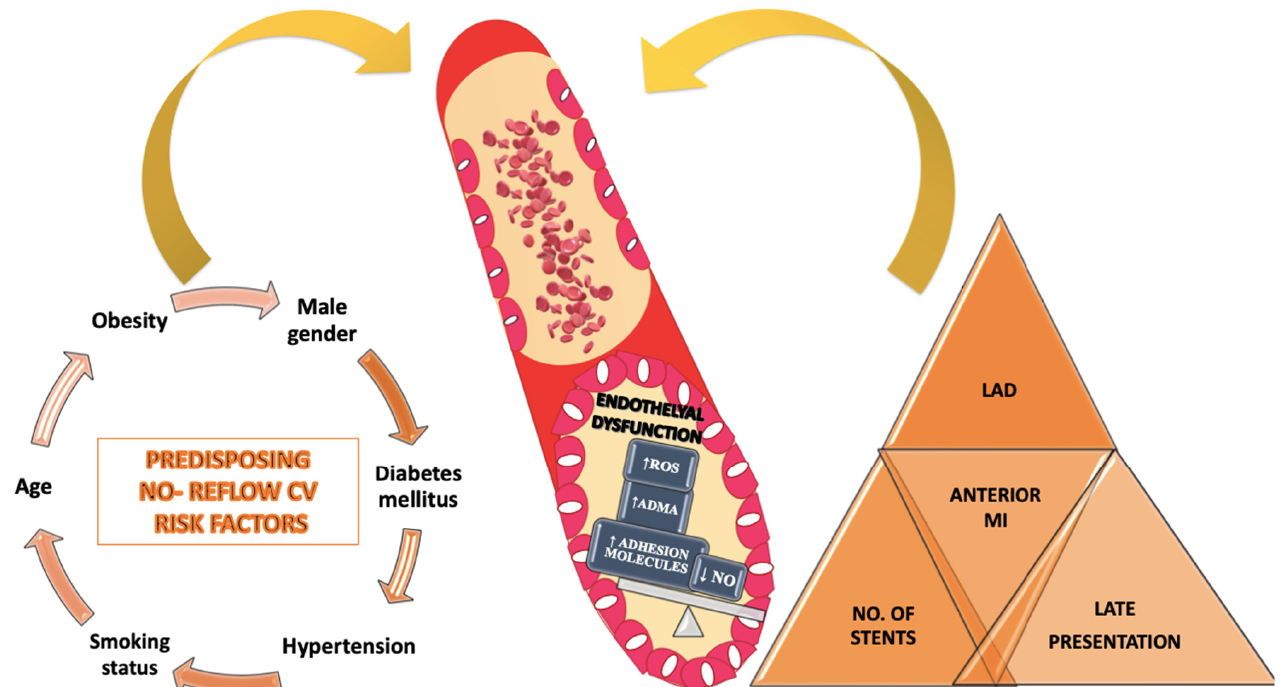
Figure 3. Predictors of the no-reflow phenomenon. ADMA, asymmetric dimethylarginine; CV, Cardiovascular; LAD, left anterior descending coronary artery; MI, myocardial infarction; NO, nitric oxide; ROS, reactive oxygen species.